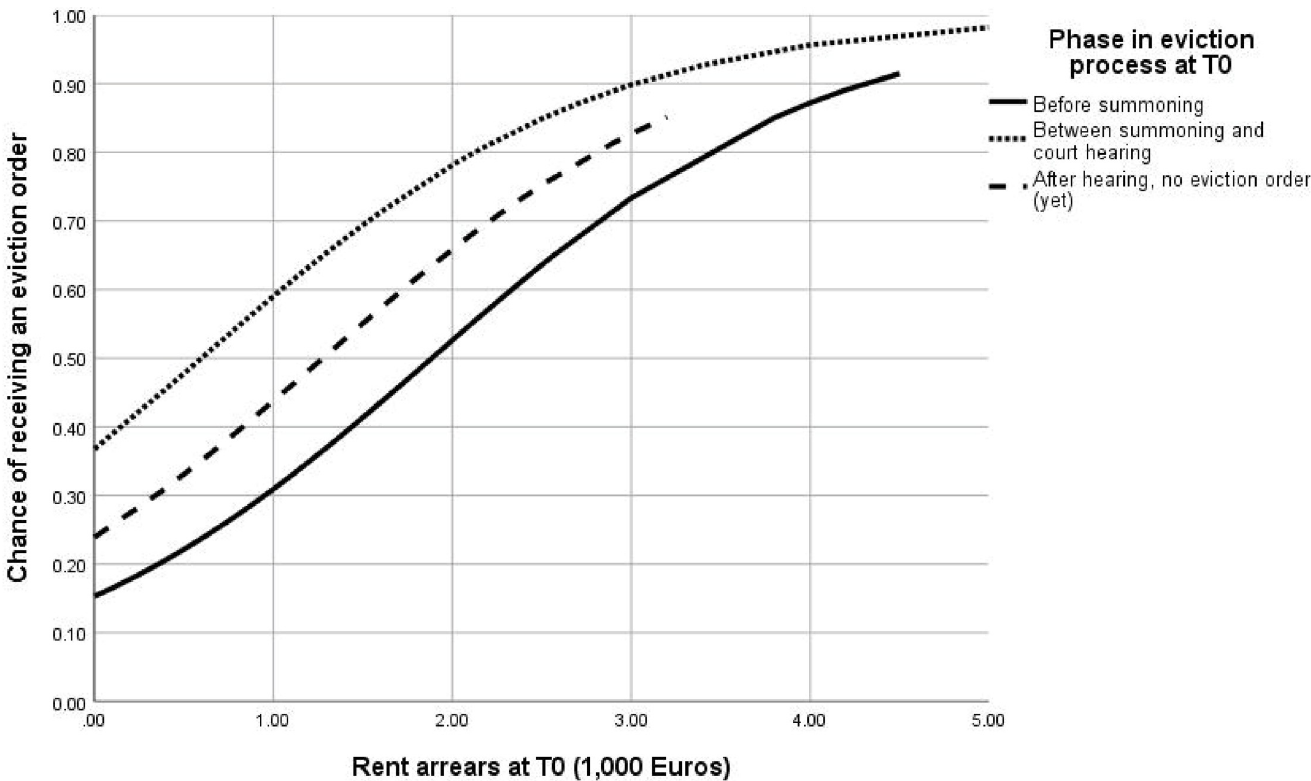
Fig 3. Probability of receiving an eviction order as a result of level of rent arrears at T0 for different phases in the eviction process, while household composition is at average level (N = 304).